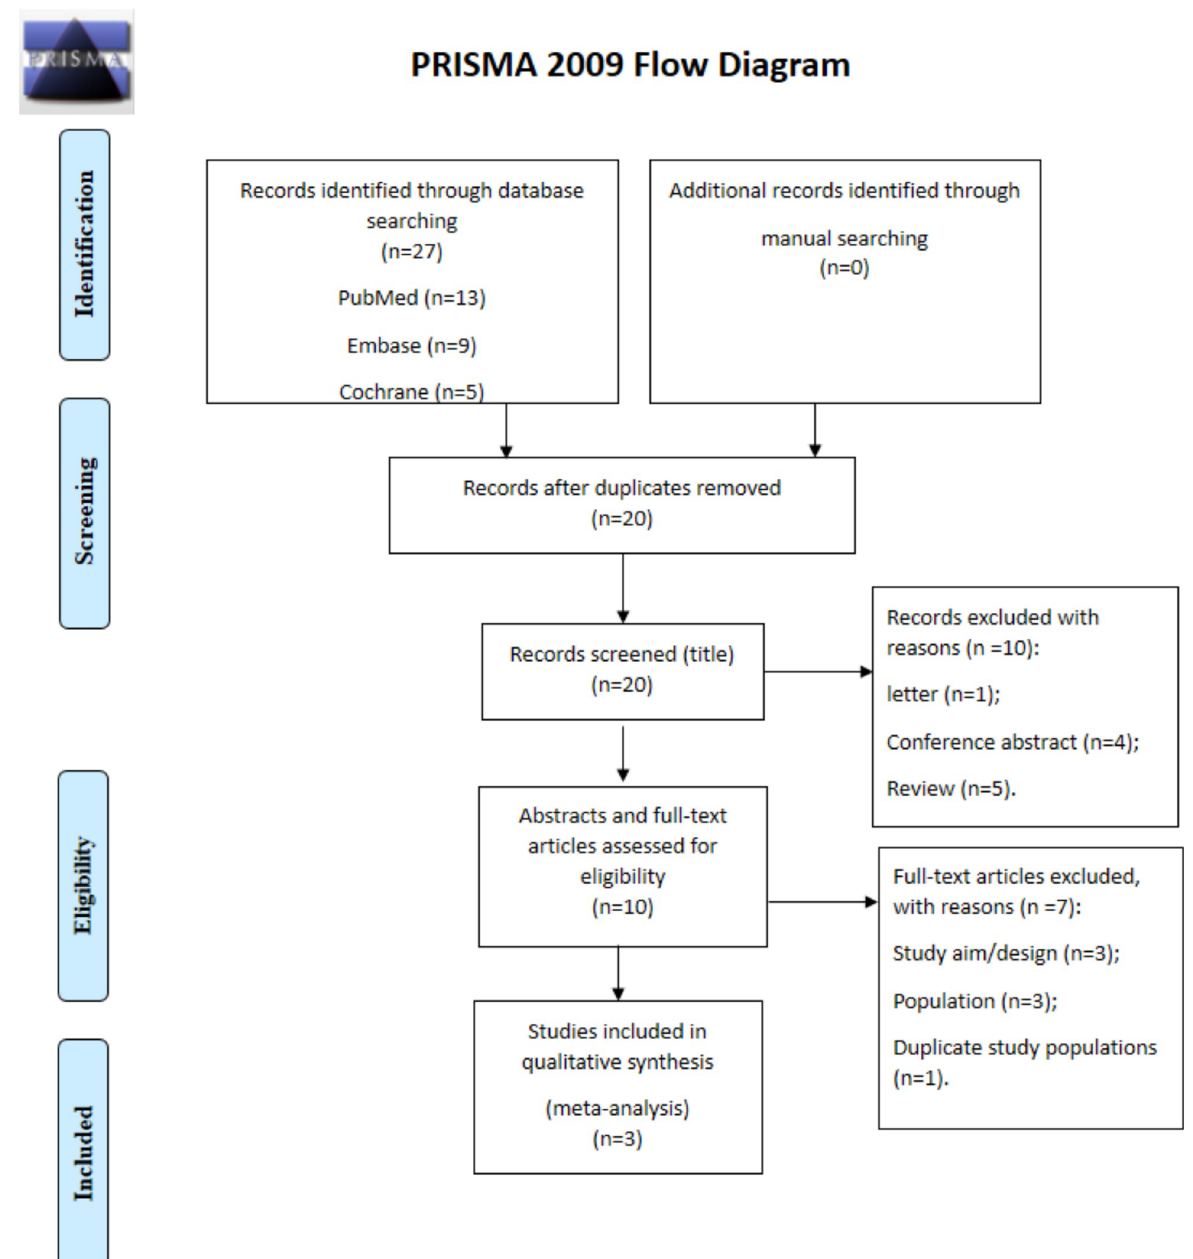
Fig 1. Study selection